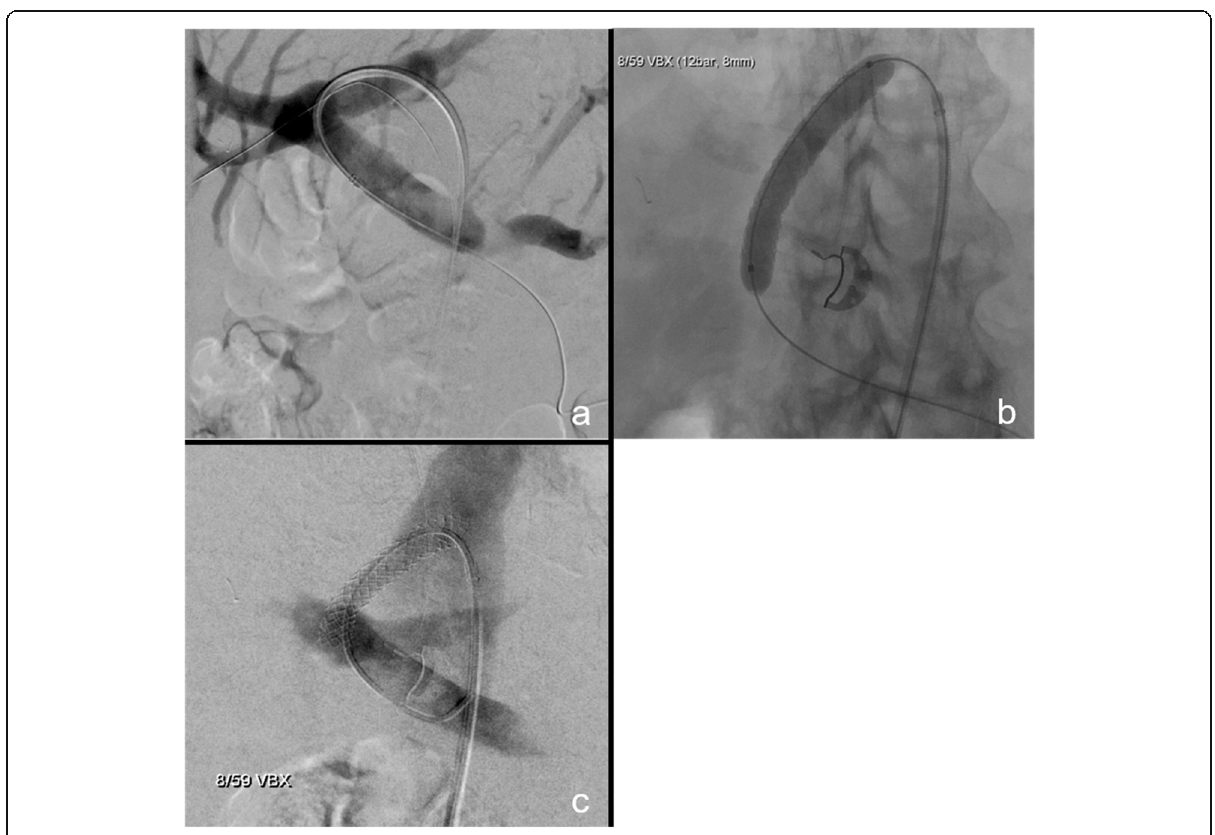
Fig. 2 Final steps of DIPS creation. A After predilation, the 8-10F sheath is brought in via the inguinal venous access and is placed in the main trunk of portal vein. An angiogram is made to ensure correct positioning. B The “ buddy wire ” is removed and the balloon-inflatable 8 mm covered stent graft is brought in via the sheath. Care is taken to make sure that the covered parts of the endograft overlap its entrances into the portal vein and IVC. C A catheter is placed in the main trunk of the portal vein after creation of the DIPS tract and an angiogram is made to ensure correct positioning and